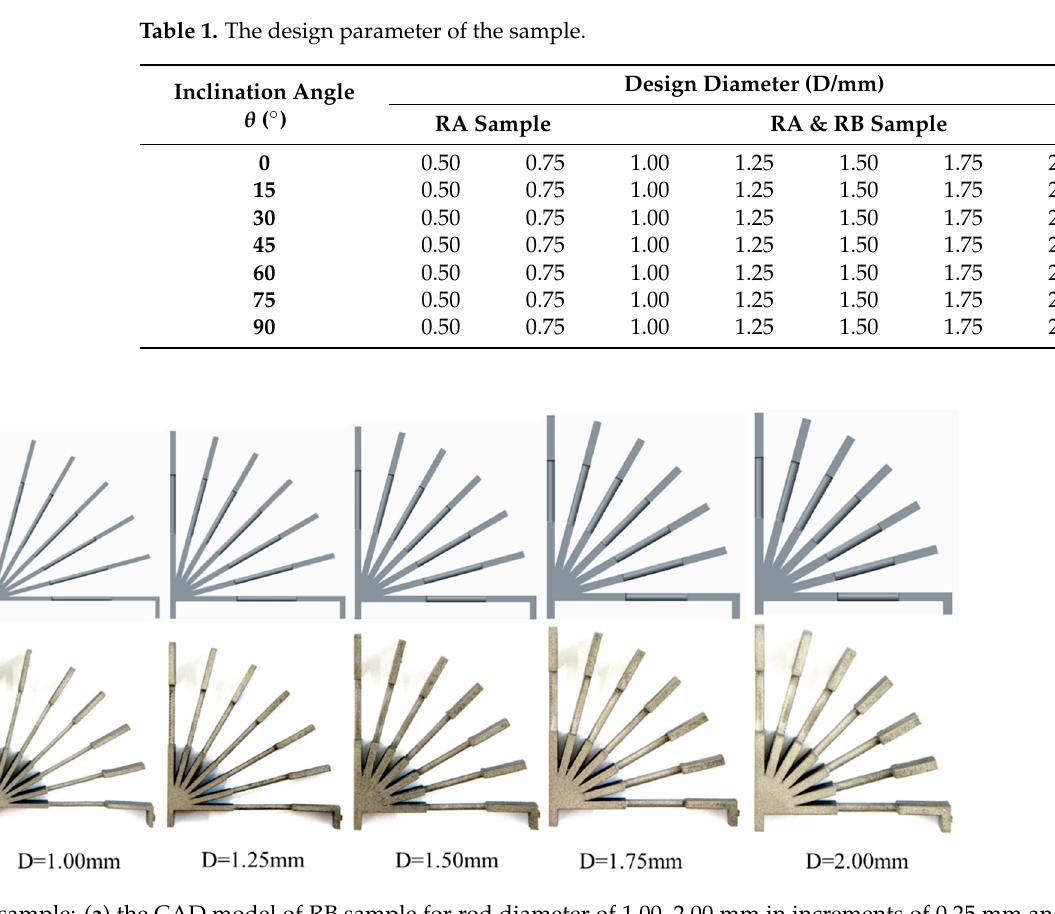
Figure 3. RB sample: ( a ) the CAD model of RB sample for rod diameter of 1.00–2.00 mm in increments of 0.25 mm and ( b ) the RB Sample manufactured by SLM. Table 1. The design parameter of the sample.